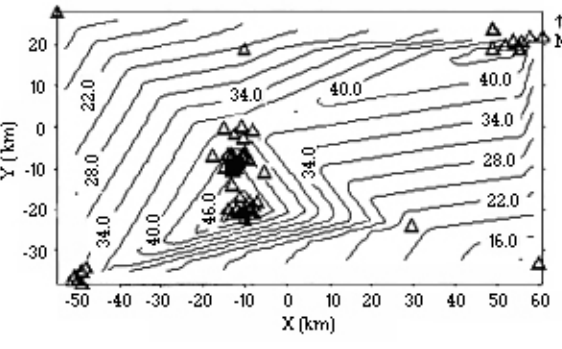
Fig. 4. The relationship between radar reflectivity and CG lightning flashes that occurred between 18:00 and 18:05(Beijing Time) on